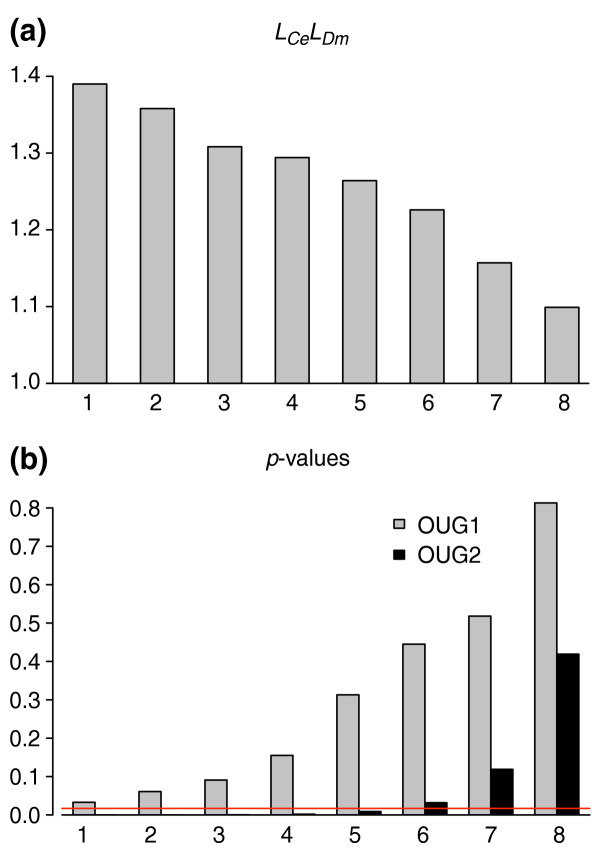
Relative rate test. (a) Relative C. elegans branch lengths derived from each one of the eight Mi matrices. Maximum likelihood estimates are expressed as relative distance units of D. melanogaster. (b) Relative rate test probability values evaluated at the 5% level family-wise (red line 1.7%). OUG1, S. cerevisae; OUG2, phylogenetic weighted scheme using S. cerevisae, A. thaliana, O. sativa and P. falciparum as outgroup species.